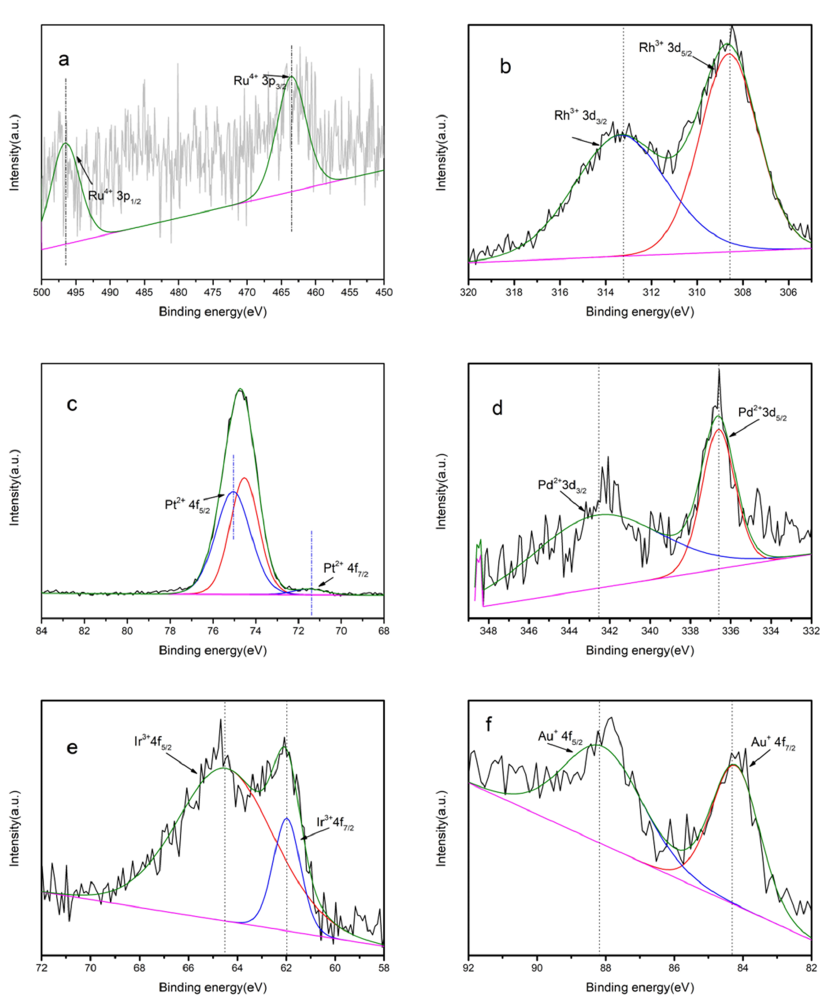
Figure 9. Ru 3 p , Rh 3 d , Pt 4 f , Pd 3 d , Ir 4 f , Au 4 f spectra of ( a ) Ru/ γ -Al 2 O 3 , ( b ) Rh/ γ -Al 2 O 3 , ( c ) Pt/ γ - Al 2 O 3 , ( d ) Pd/ γ -Al 2 O 3 , ( e ) Ir/ γ -Al 2 O 3 , ( f ) Au/ γ -Al 2 O 3 catalysts.